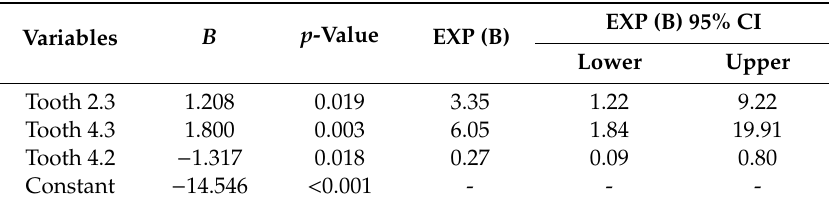
Table 2. Final reduced logistic regression model (n = 168).